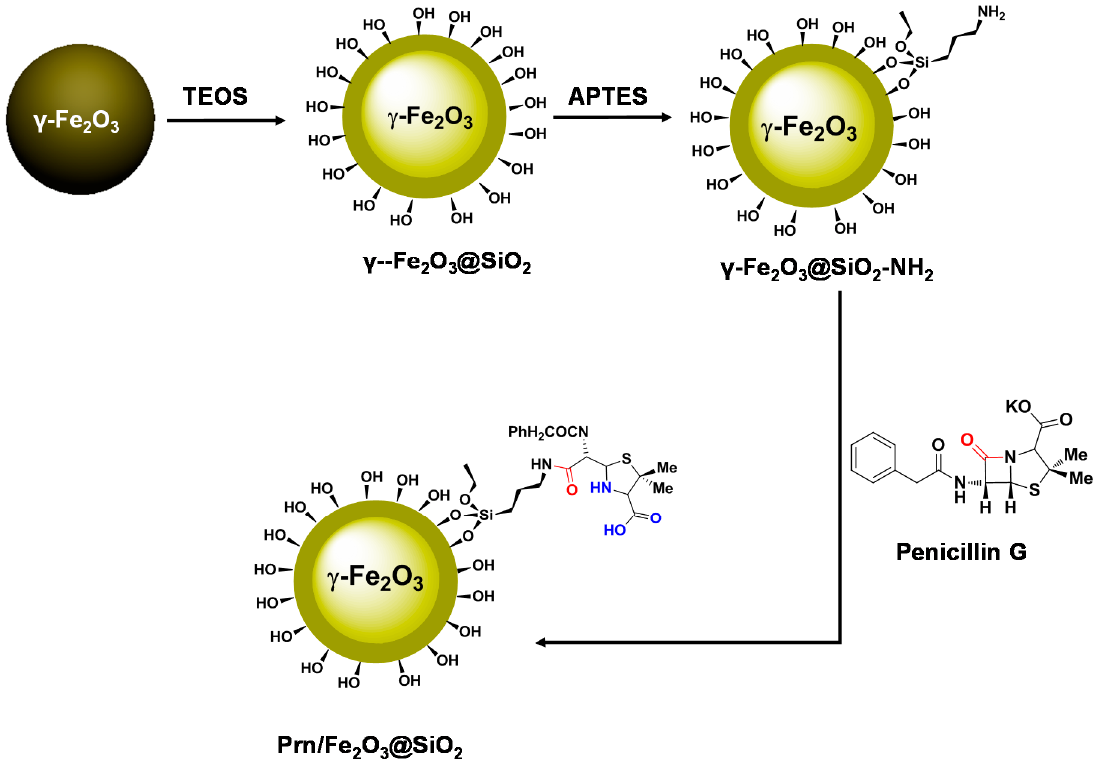
Figure 1. Overview of the preparation of Prn/Fe 2 O 3 @SiO 2 magnetic organocatalyst.